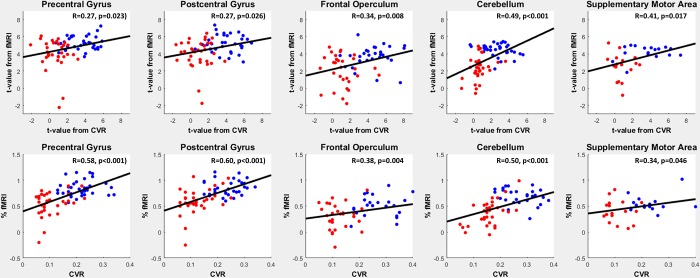
Upper row: Scatterplot of the t-values obtained from the BOLD-CVR and the fMRI finger tapping data.Lower row: Scatterplot of BOLD-CVR % signal change and %fMRI signal change for each ROI and subject. Each red and blue point represents the average value of a ROI of a single subject during either normocpanie (blue) or hypercapnia (red). Black line: least square error linear fit of each scatterplot. Abbreviations: BOLD: blood oxygenation-level dependent; -CVR: cerebrovascular reactivity, CO2: carbon dioxide, %fMRI: mean percent BOLD signal changes, ROI: Region of Interest.